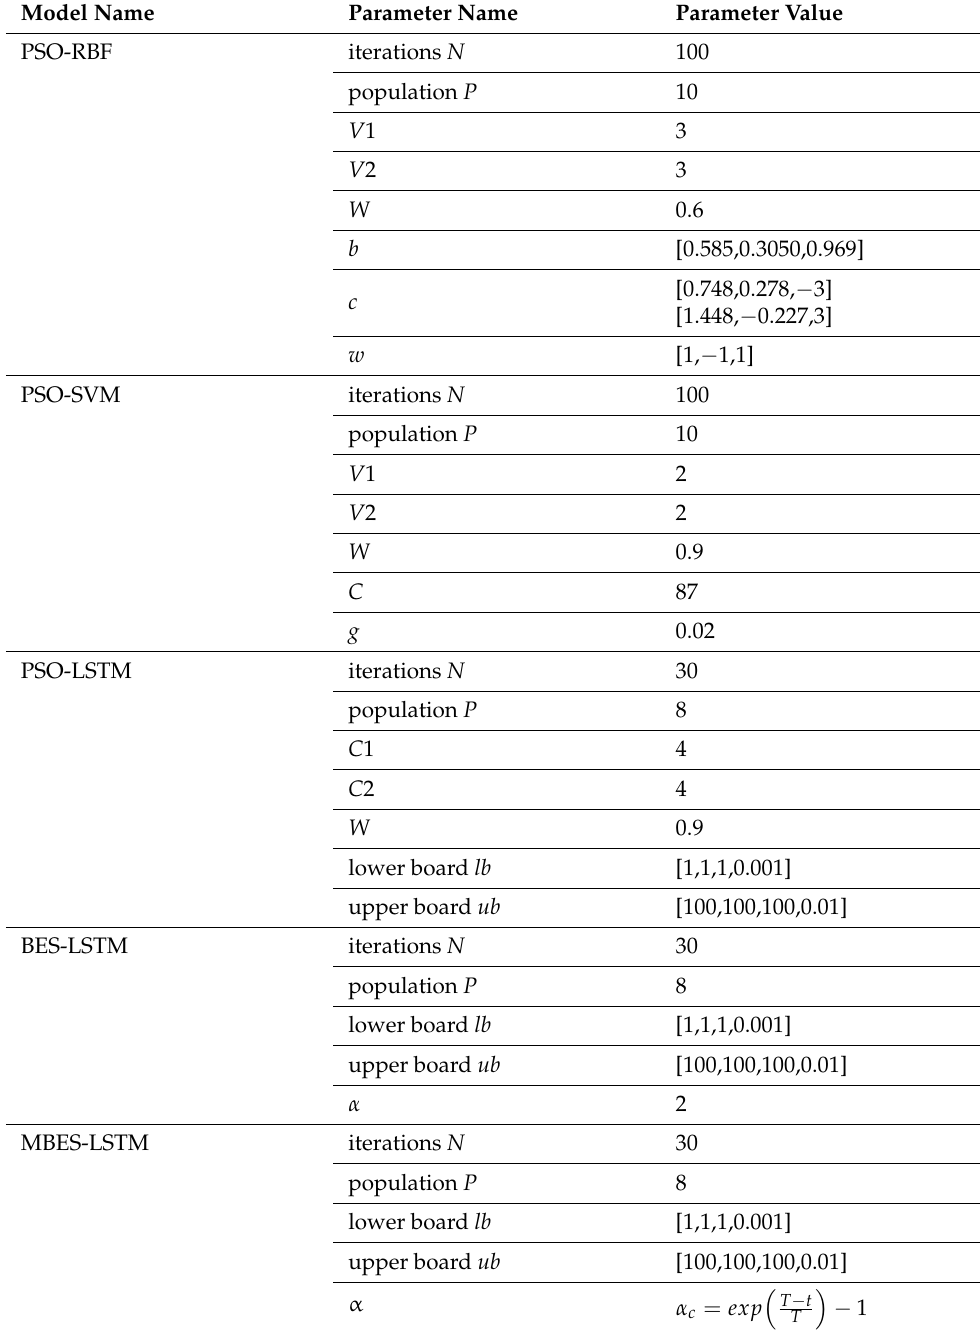
Table 7. The parameter values of PSO-RBF, PSO-SVM, PSO-LSTM, BES-LSTM, and